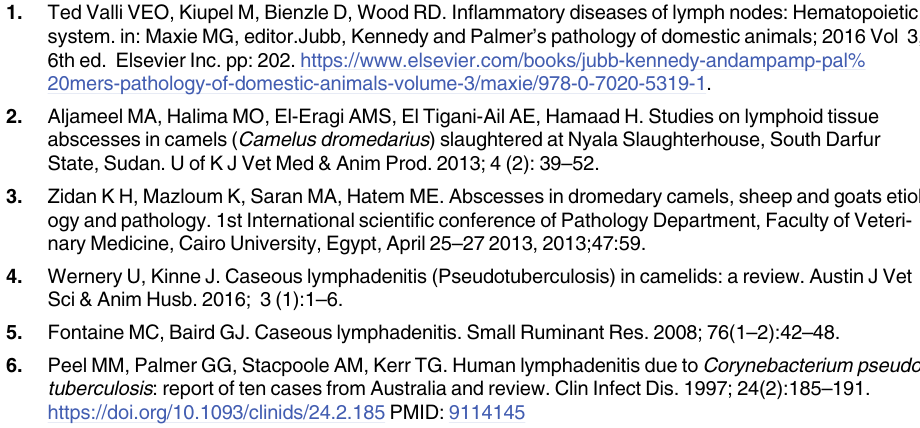
S2 Fig. VITEK-MS (MALDI-ToF). (BioMe´rieux, Marcy l’Etoile, France), confirmation of Corynebacterium pseudotuberculosis isolates with a confidence value of 99.9%. (TIF) S1 Raw images. A raw gel image of Fig 3 showing PCR amplified 16S rRNA gene (partial, ~ 900 bp) for the 12 samples used in the